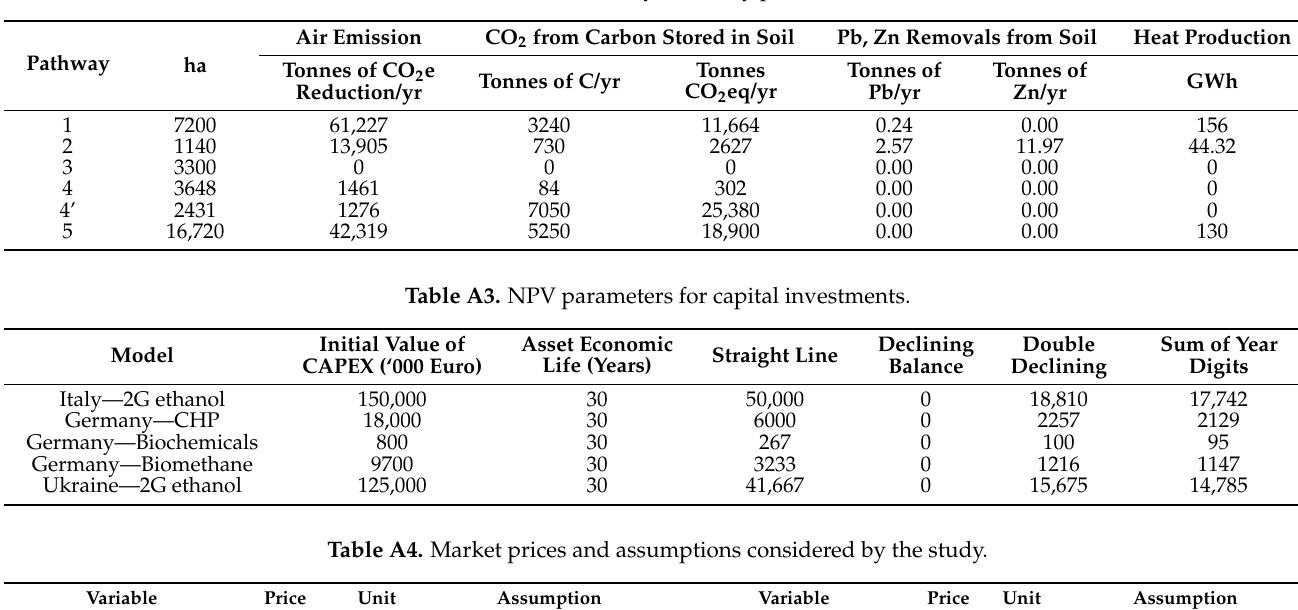
Table A2. Positive externalities considered by the study per each of the selected investment.